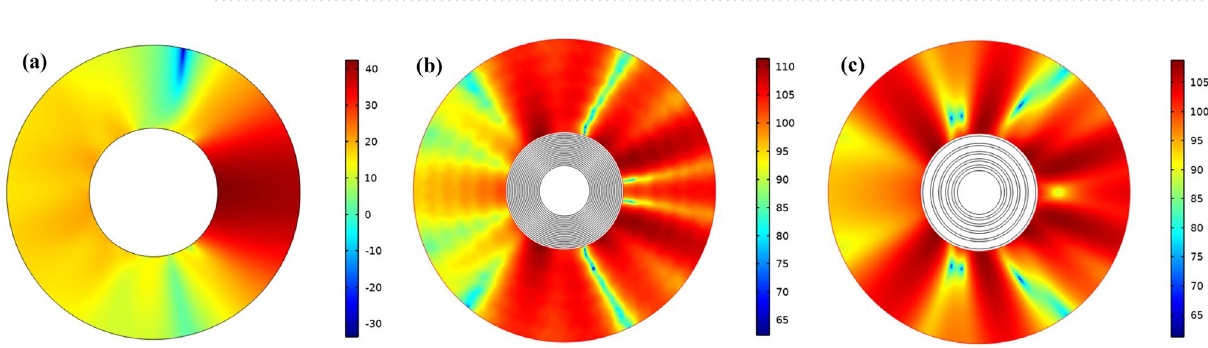
Figure 7. The total sound pressure level for ( a ) homogeneous cloaking, ( b ) multi-layers cloaking with 20 layer and ( c ) composite lattice cloaking.